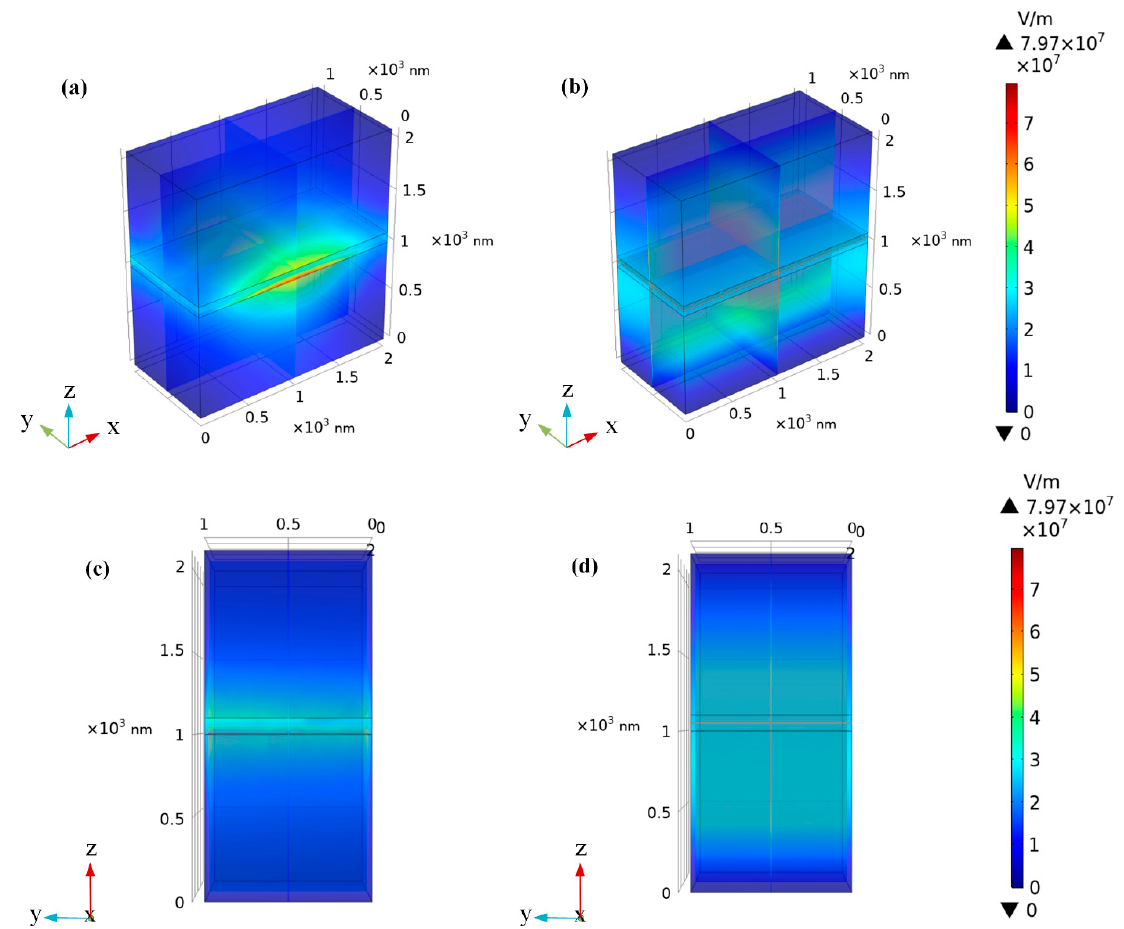
Figure 8. Electric field distribution of the structure in 1000 nm structure width: 3D layout waveguide structure in the ( a ) 1416.81 cm − 1 and ( b ) 1611.11 cm − 1 wavenumber; and cross-section of the yz plane in the ( c ) 1416.81 cm − 1 and ( d ) 1611.11 cm − 1 wavenumber.